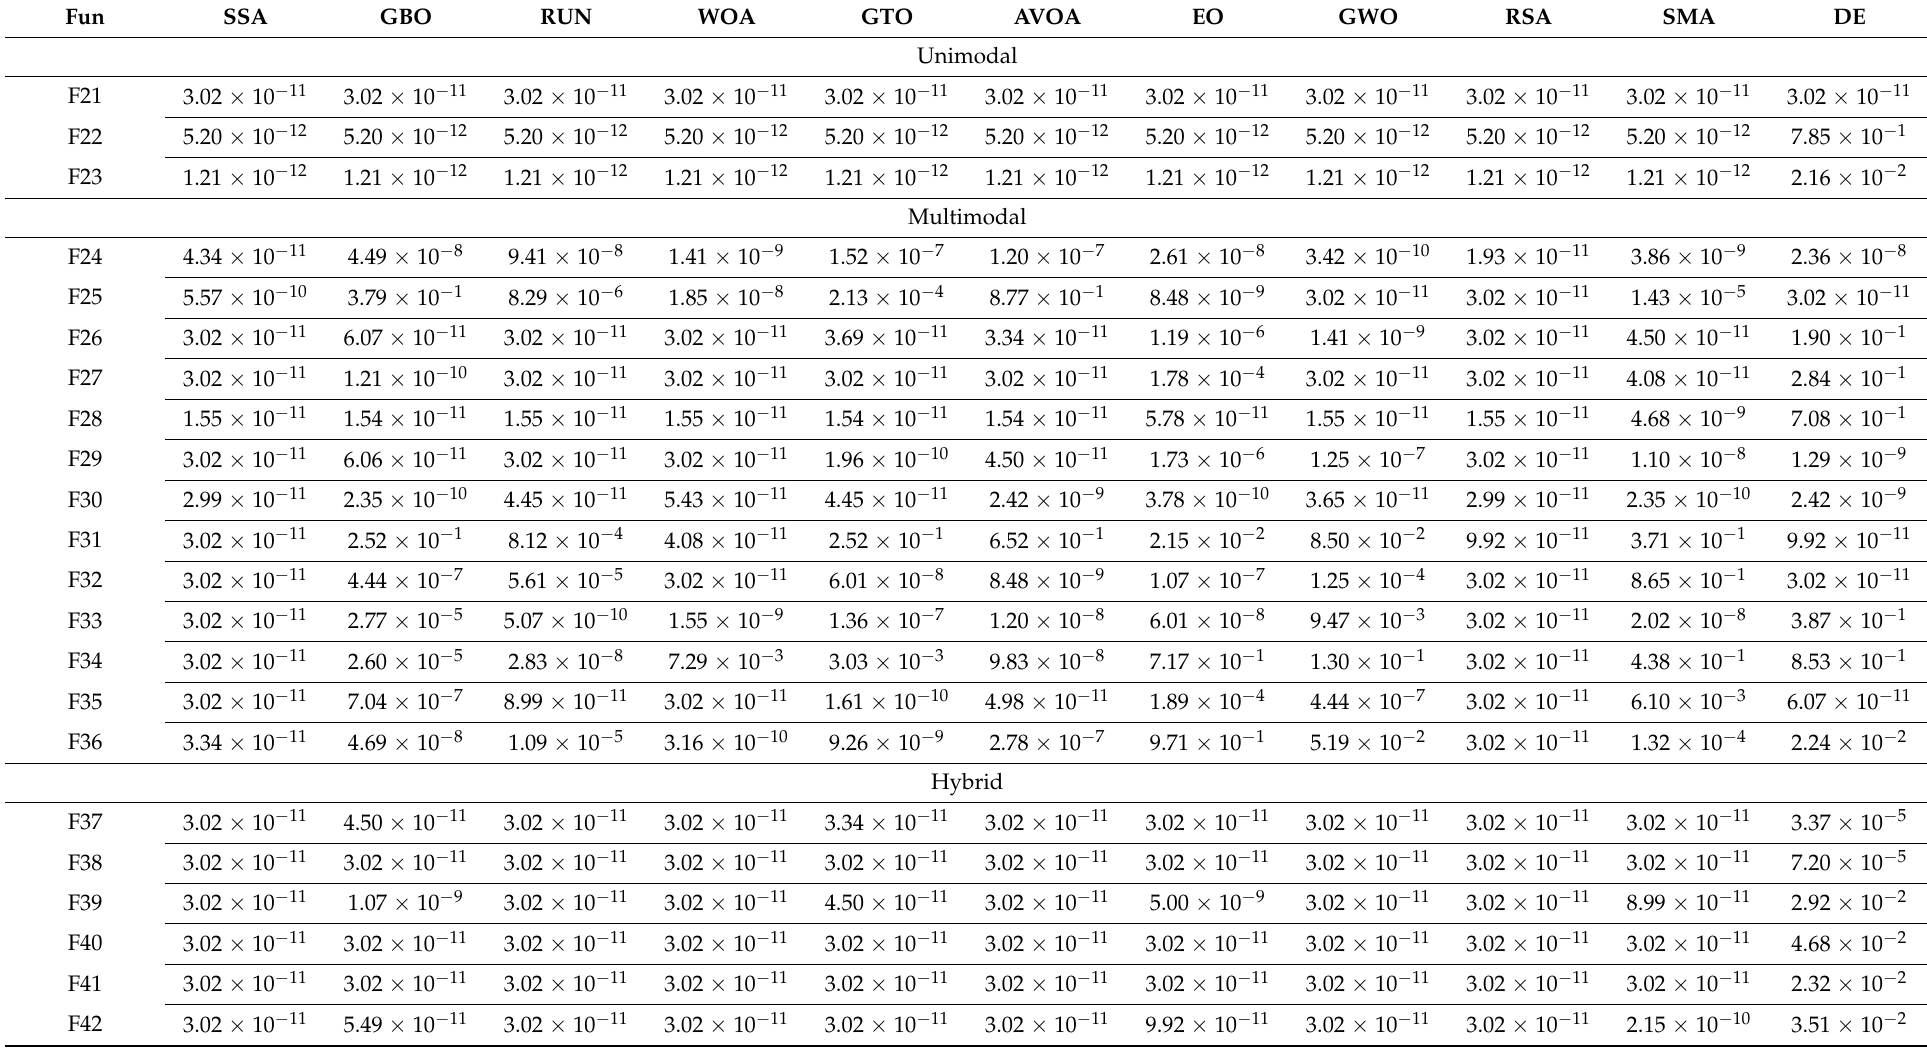
Table 9. p -values of LSO with each rival optimizer on CEC-2014 test suite